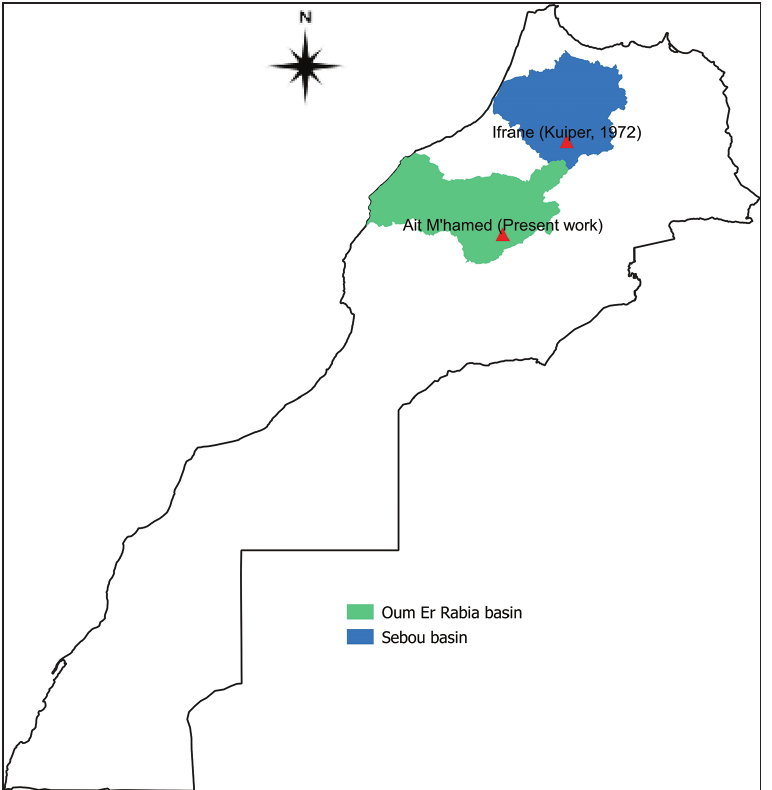
Figure 6. Map of occurrence localities of Pisidium subtruncatum from this paper and previous record (red